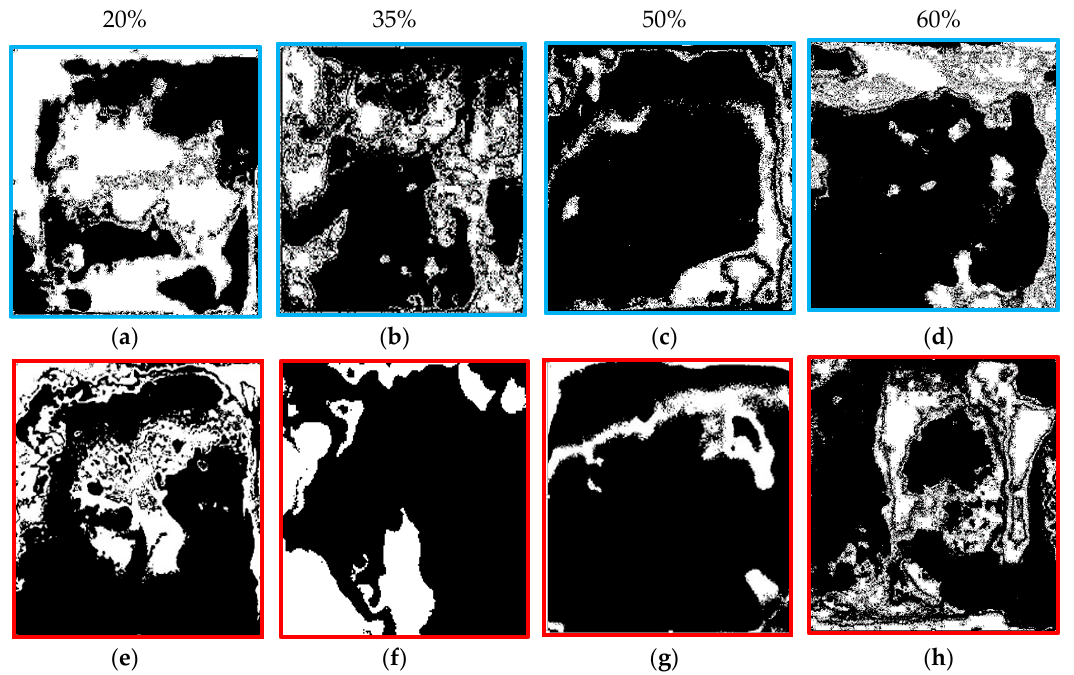
Figure 7. Optical photographs of failure interface between current collector (white color) and BCC (black color) containing various carbon black contents (CMC/SBR: ( a )–( d ); SA: ( e )–( h )).